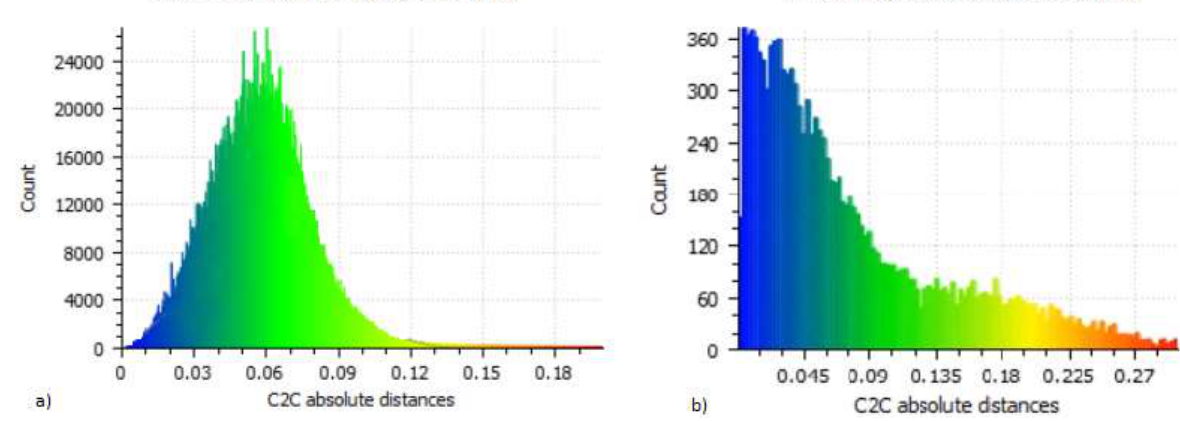
Figure 6 . Difference between the DIM (a) and ULS (b